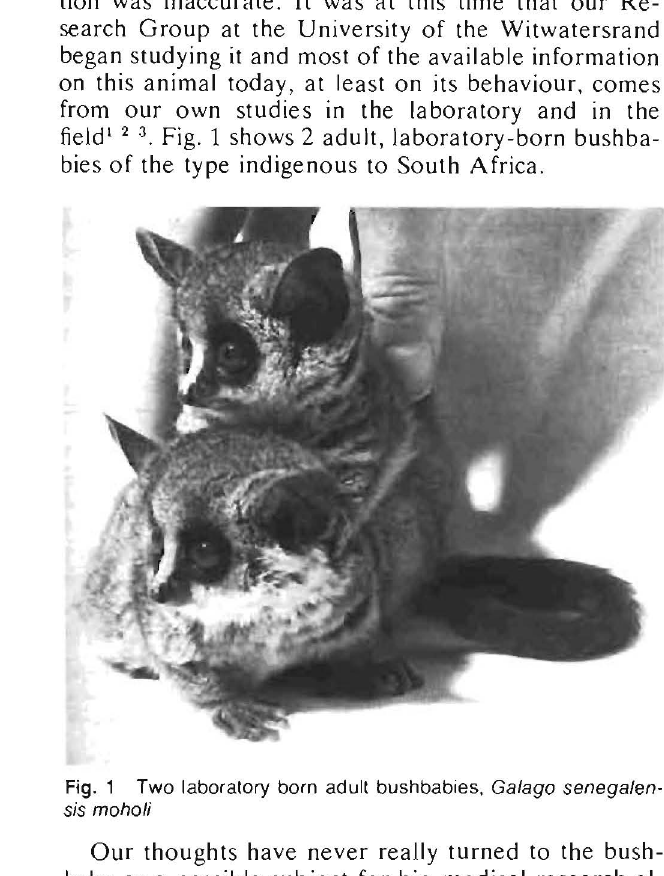
Table 1: BODYMASS OF ADULT G.S.MOHOLI UNDER LABORATORY